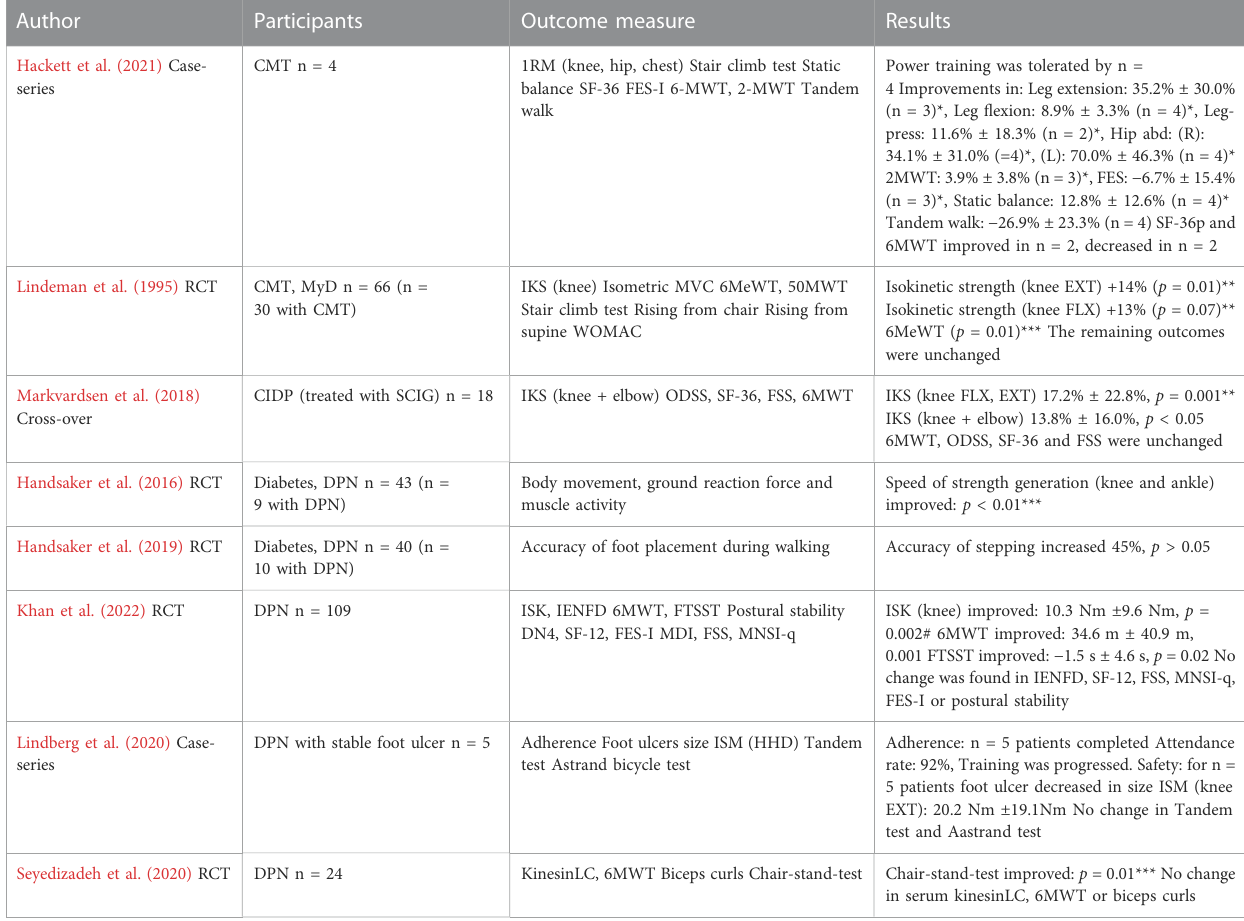
TABLE 2 Strength training interventions — outcome measures and